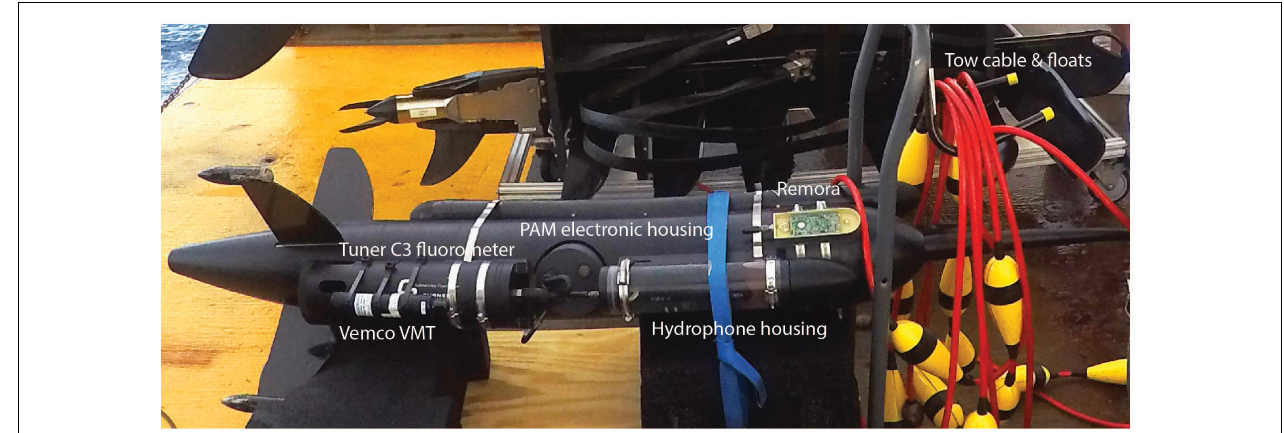
FIGURE 2 | Components and payload of the wave glider’s